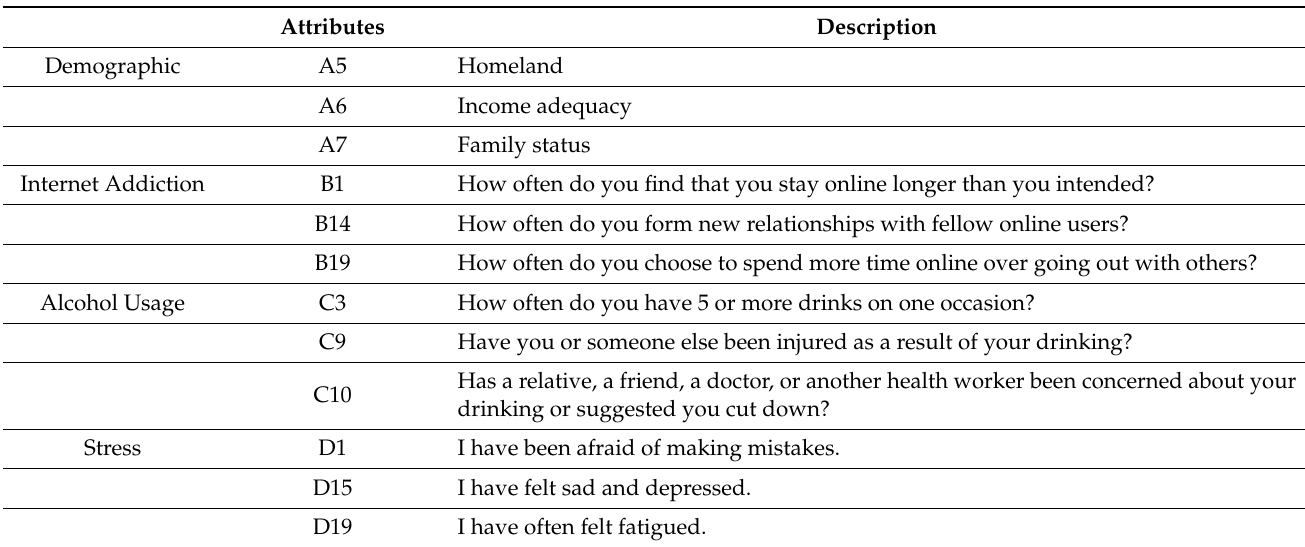
Table 8. Selected attributes involved in each type by using the Relief technique.